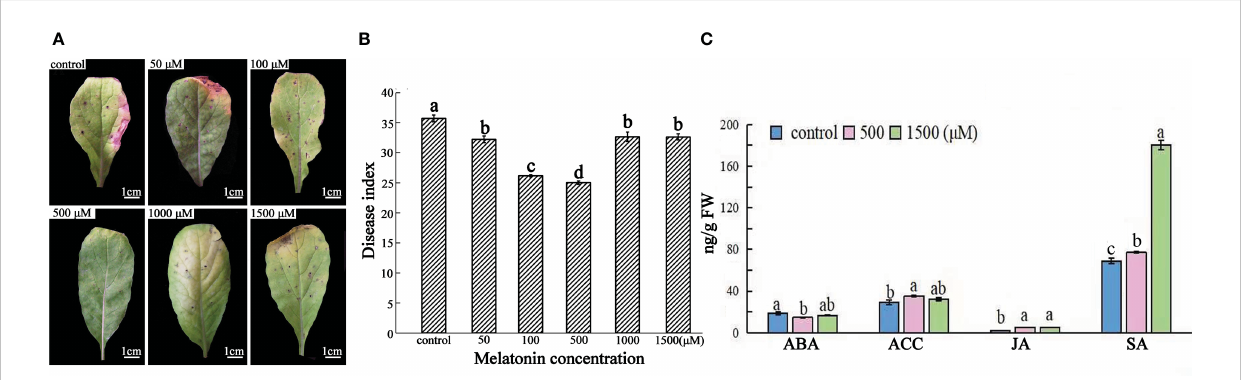
FIGURE 5 Effects of exogenous MT at different concentrations on radish “ JNYB ” defense to A brassicae and levels of innate phytohormones. Black spot-diseased radish seedlings were exogenously spayed with 0-1500 m M exogenous MT once two days for 15 days. (A) Representative 2 nd expanded leaves of diseased seedlings of each treatment. (B) Average disease index (DI) for each treatment. (C) ABA, ACC, JA, and SA contents for the control, 500, and 1500 m M MT treatments. Effects of MT were signi fi cantly dose dependent. At least three repeats were performed for each sample, and the values presented are the means ± SE. Letters indicate signi fi cant difference and statistical analysis was performed by one-way ANOVA, p <